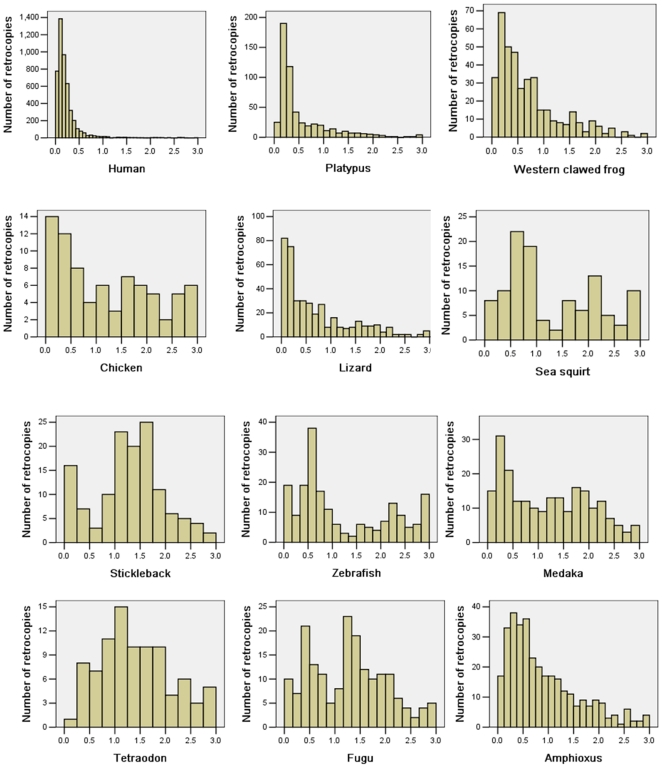
Ks distribution of retrocopies in 12 chordates.The Ks values were obtained through comparing retrocopies and corresponding parental genes.